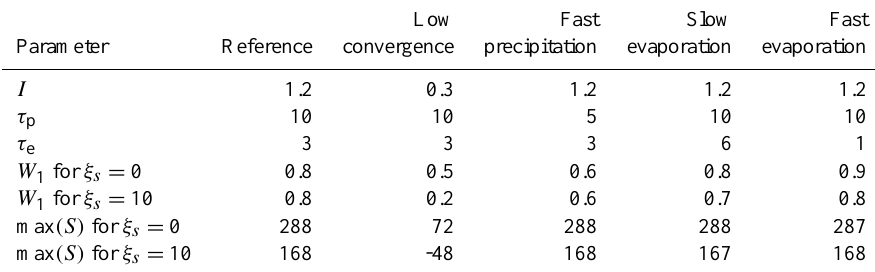
Table 3. Parameter values of the examples of Fig. 4 and corresponding equilibrium moisture W 1 and maximum soil moisture max (S) for two different values of ξ s (for ξ s = 10 mm month − 1 , one of the parameter sets leads to a negative max( S ), i.e. this parameter set is physically not possible); units and other parameter values as in Table